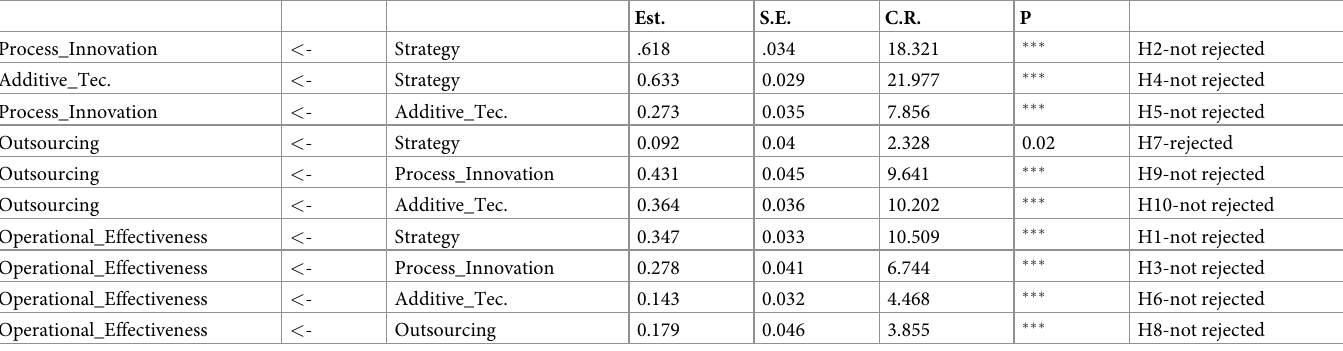
Table 4. Regression weights: (Group number 1—Default